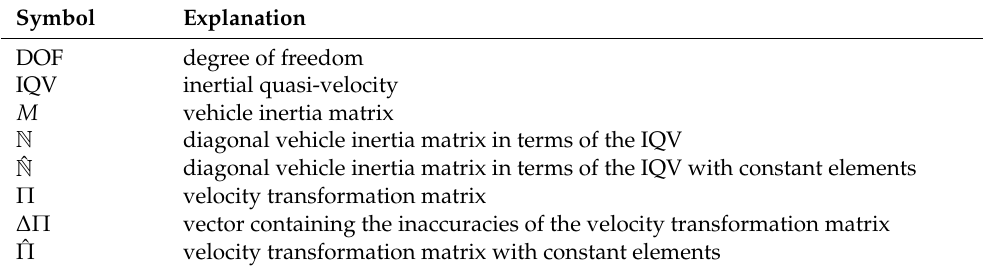
Table A1. Explanation of symbols and